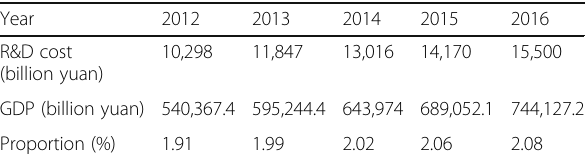
Table 3 R&D cost and proportion in GDP